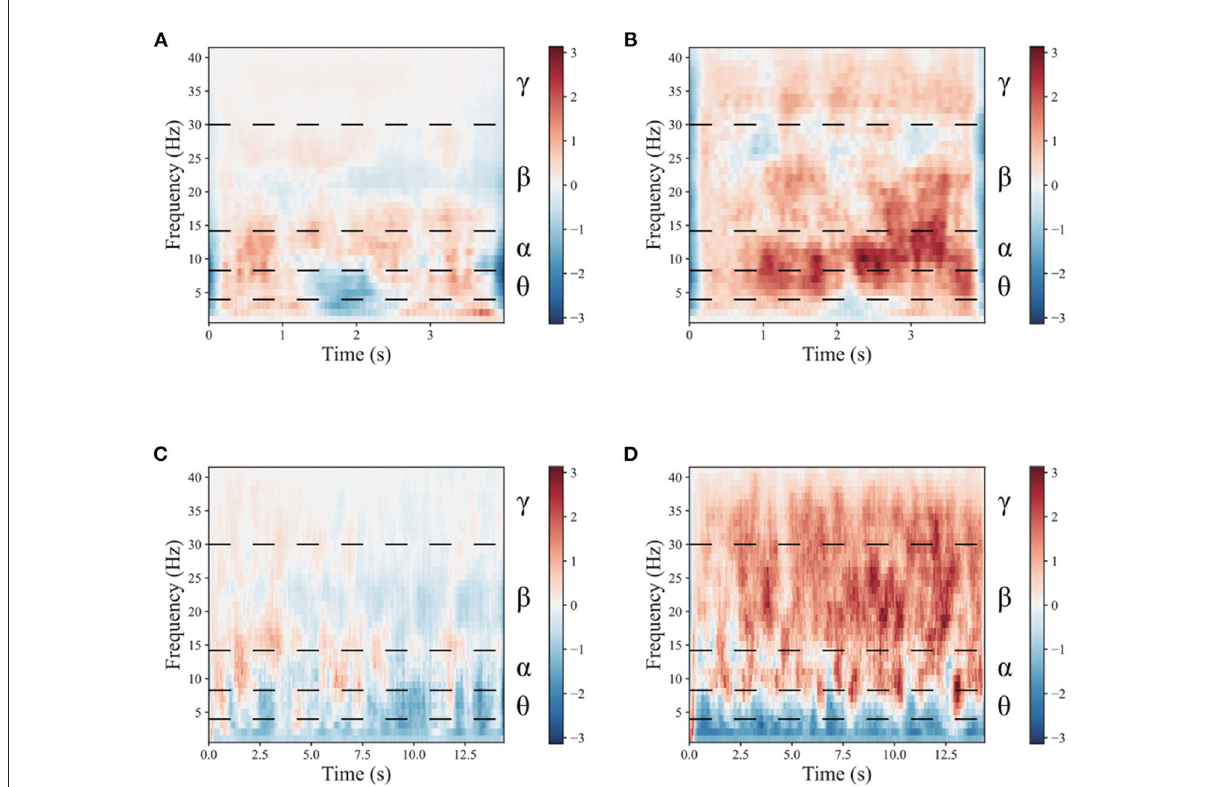
FIGURE5 The mean time-frequency of the lower limb movement imagery with and without stimulation in CPZ electrodes from all subjects of the in-house dataset. (A) The rest state imagery without stimulation. (B) Lower limb movement imagery without stimulation. (C) The rest state imagery with stimulation. (D) Lower limb movement imagery with